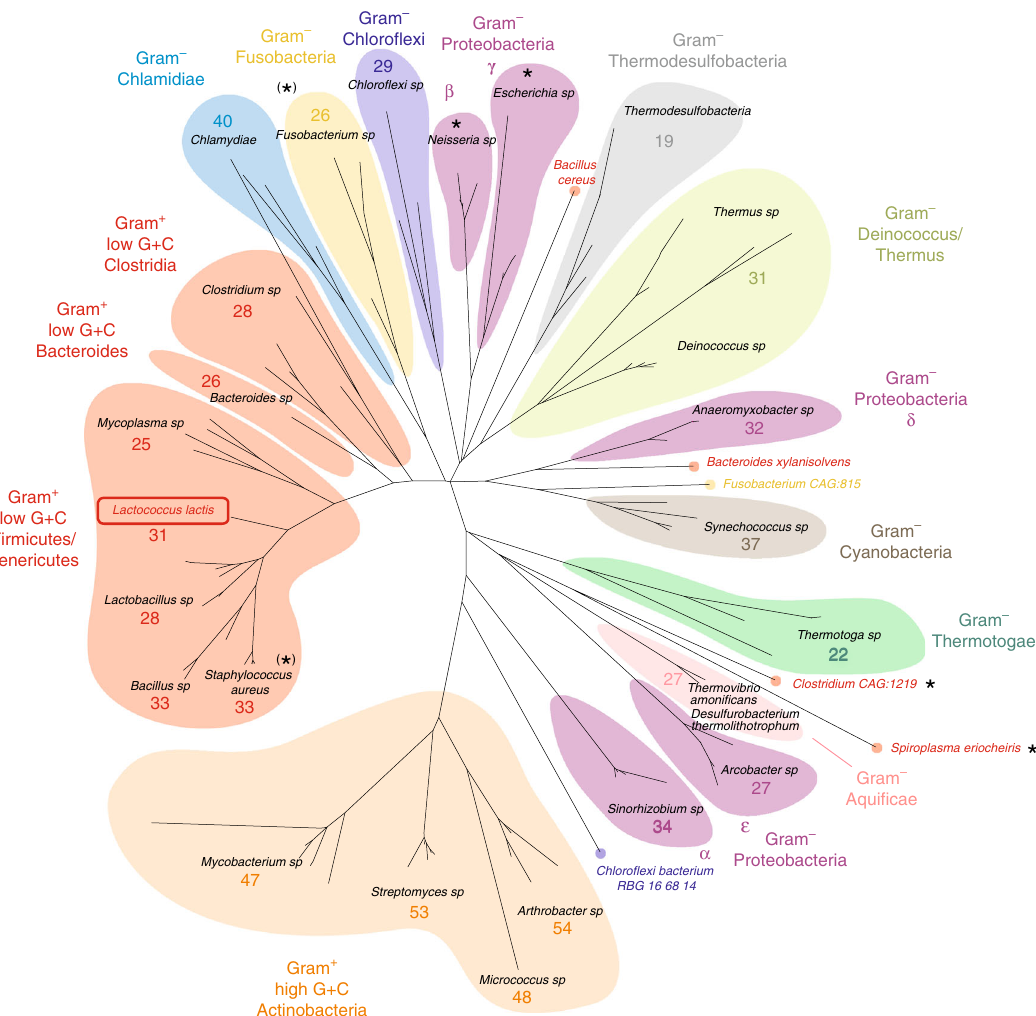
Fig. 5 Phylogenetic tree of HPF homologs. The tree is based on 110 proteins homologous to HPF long from L. lactis . The average linker length of HPF long is given by the number of residues in each of the